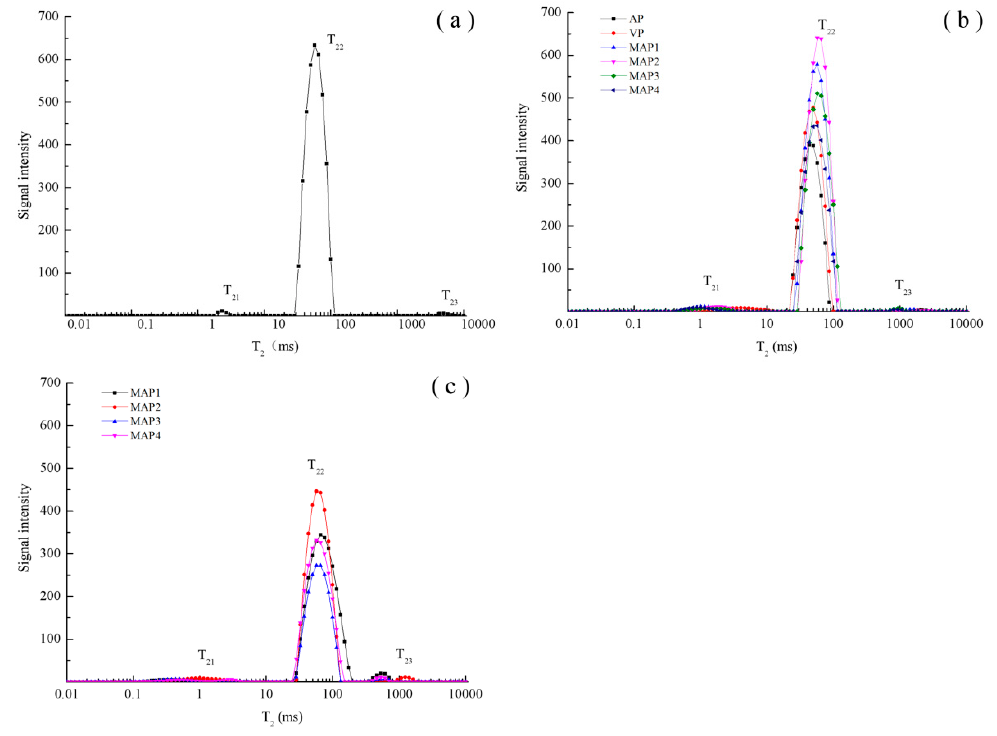
Figure 2. T 2 relaxation time distribution curves of turbots under different treatments on the 0 ( a ), 15th ( b ) and 27th ( c ) day of the storage period (T 21 , bound water; T 22 , immobilized water; T 23 , free water; AP: air packing; VP: vacuum packing; MAP1:70% CO 2 / 30% N 2 ; MAP2: 60% CO 2 / 10% O 2 / 30% N 2 ; MAP3: 50% CO 2 / 15% O 2 / 35% N 2 ; MAP4: 55% CO 2 / 5% O 2 / 40% N 2 ).